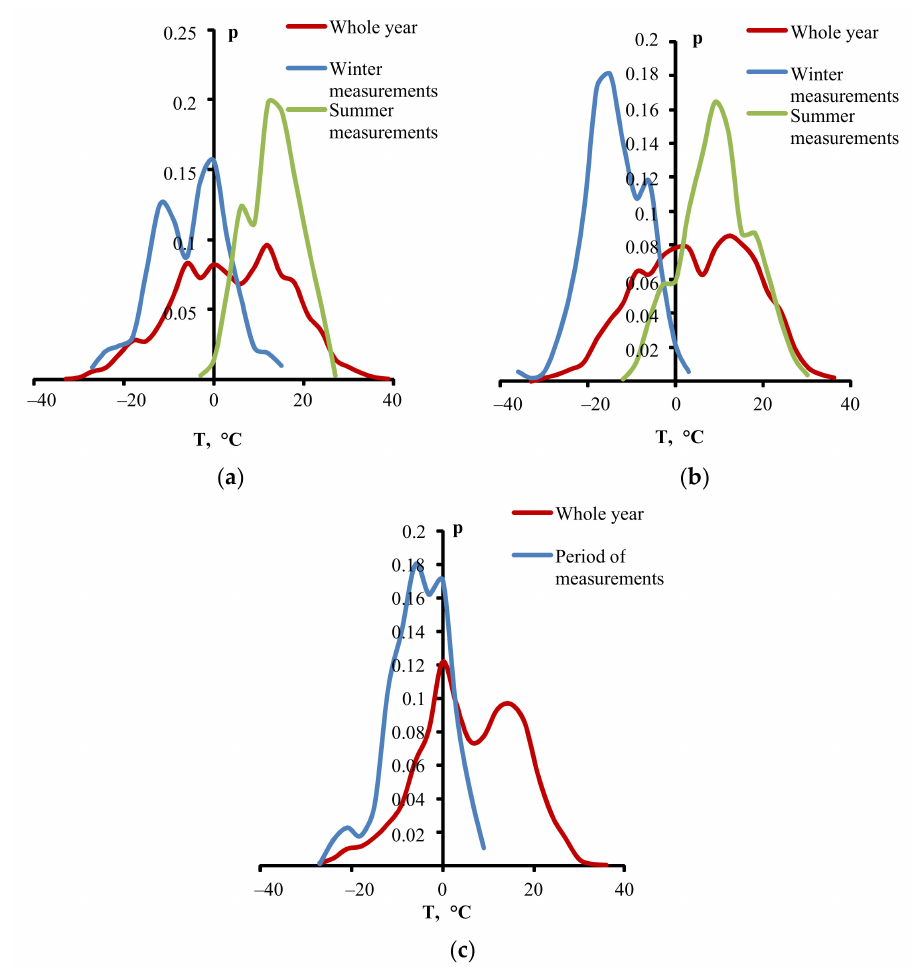
Figure 3. Distribution of three-hour temperatures during integrated measurements during paired measurements ( a ) Ekaterinburg, ( b ) Chelyabinsk, ( c ) Nizhny